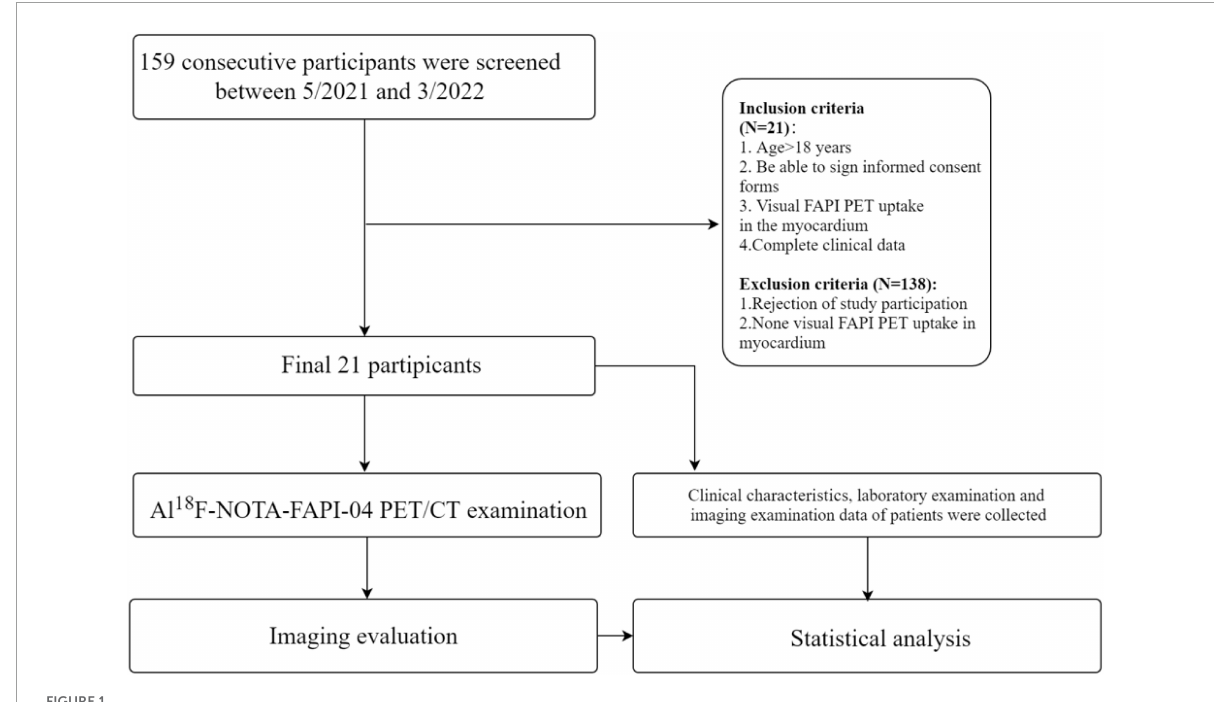
FIGURE1 Study flow chart. Patients were consecutively